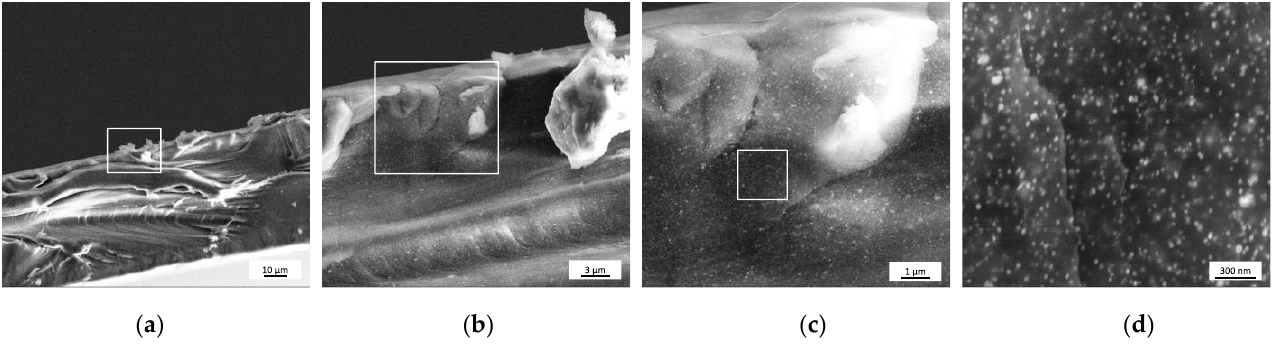
Figure 5. SEM images of ( a ) F3Ag sample cross-section and corresponding (from left to right) ( b – d ) higher magnification of the areas highlighted in white.